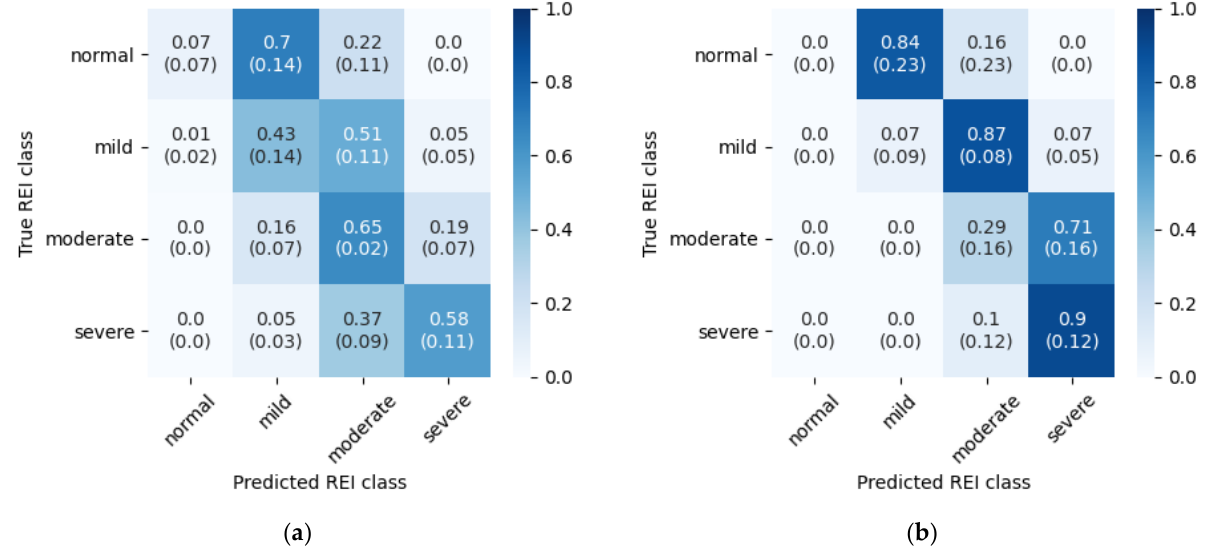
Figure 7. Row-normalized confusion matrices for REI classification ( a ) Test set from SHHS-1 database; ( b ) PhysioNet Sleep Database.